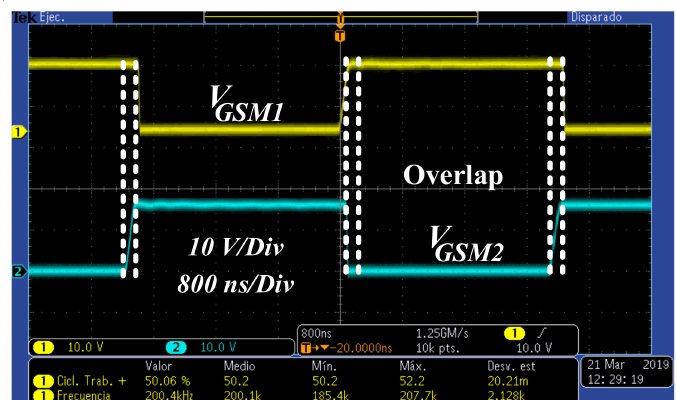
Figure 14. Overlapping signals performed for the third array.